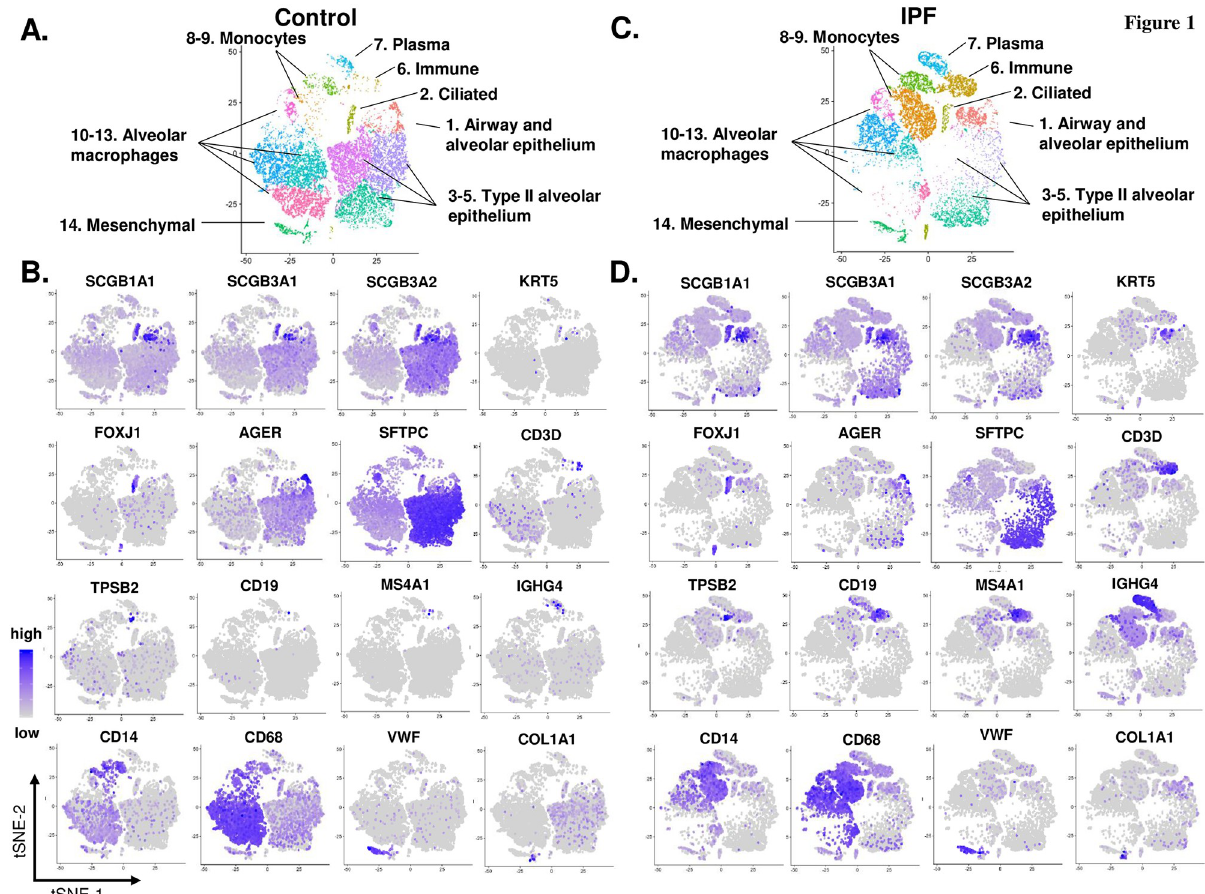
Fig 1. Identification of unique cell populations from the human lungs of controls vs IPF patients by single cell RNA-sequencing. Based on the data of Reyfman et al [13], 18,887 single cells from the lungs of 4 controls and 13,256 single cells from the lungs of 4 IPF patients (see S1 Table in S1 File for the detailed information of controls and IPF patients) were generated from the data in NCBI Gene Expression Omnibus (GEO accession number: GSE122960). A. Unsupervised t-distributed Stochastic Neighbor Embedding (t-SNE) clustering of the single cells from the lungs of 4 controls. A total of 14 unique cells populations were identified. B. Expression of the canonical markers of the different cell populations from control human lungs in the t- SNE plot shown in panel A. Club cell markers–SCGB1A1, SCGB3A1 and SCGB3A2; basal cell–KRT5; ciliated cell–FOXJ1; type I alveolar cells–AGER; type II alveolar cells–SFTPC; T cells–CD3D; mast cells–TPSB2; B cells–CD19 and MS4A1; plasma cells–IGHG; monocytes–CD14; alveolar macrophages–CD68; endothelial cells–VWF; and fibroblasts–COL1A1. C. Unsupervised t-SNE clustering of the single cells from the lung of 4 IPF patients. The same 14 cell populations were identified in IPF patients, as in the controls. D. Expression of the canonical markers of the different cell populations from in the IPF t-SNE plot shown in panel C. The markers are the same as in panel B. Based on signature genes (see S2 and S3 Tables in S1 File) and the expression of canonical markers of the different cell populations, the 14 cell populations identified in panels A. and C. were defined as: 1. airway (including basal and club cells) and alveolar (including type I and II alveolar cells) epithelial cells; 2. ciliated; 3–5. type II alveolar cells; 6. immune cells (including T cells, mast cells and B cells); 7. plasma cells; 8–9. monocytes; 10–13. alveolar macrophages; and 14. mesenchymal cells (including endothelial cells and fibroblasts).